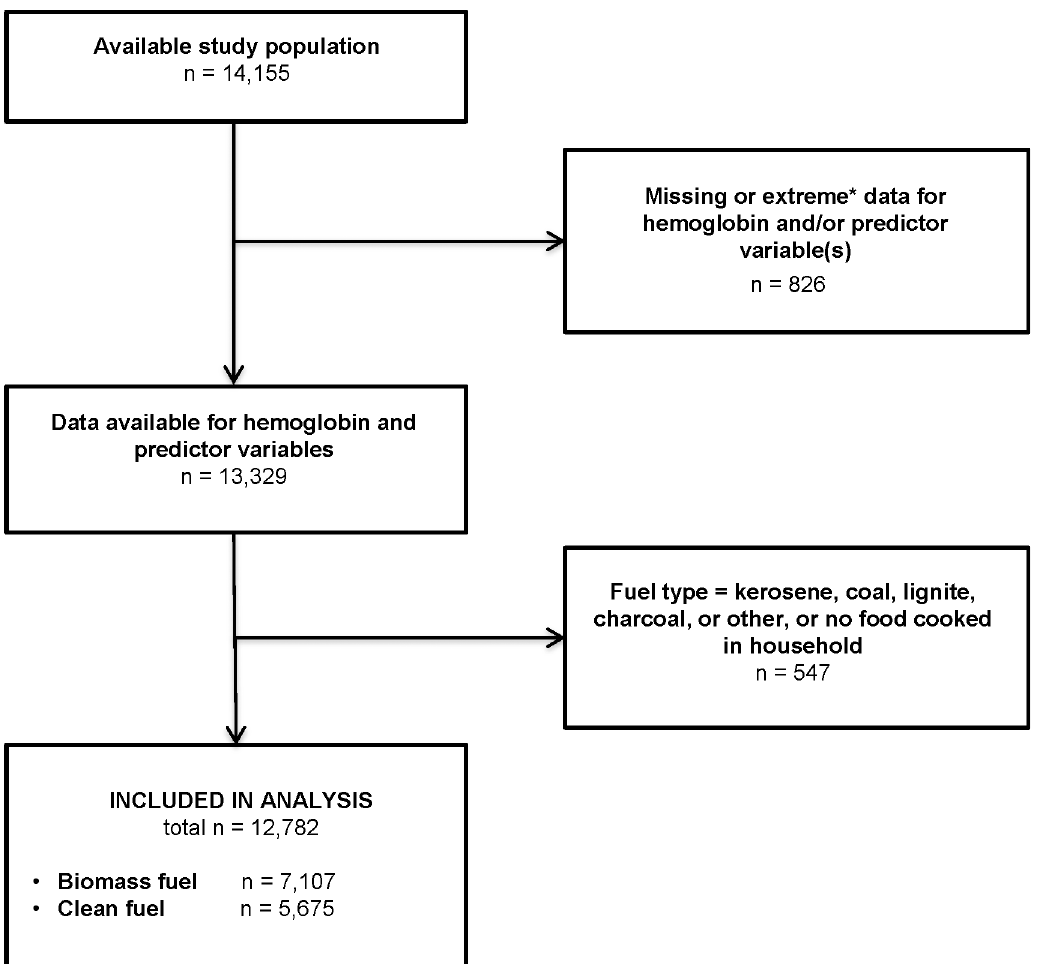
Fig 1. Flow diagram of study participants. Extreme values: for hemoglobin, hemoglobin (cid:3) 2 g/dl; for body mass index (BMI), height (cid:3) 120 cm or weight > 90 kg; for trimester, gestational age (as determined by last menstrual period) < 5 weeks or > 42